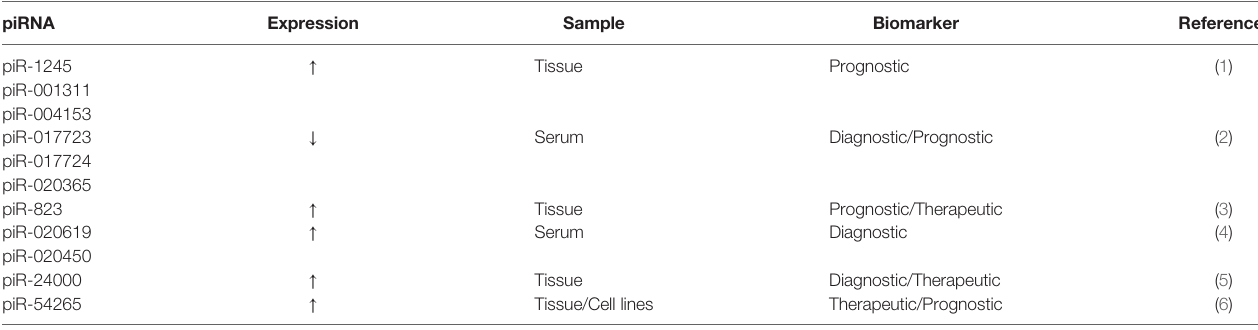
TABLE 5 | piRNAs as potential biomarker for colorectal cancer.